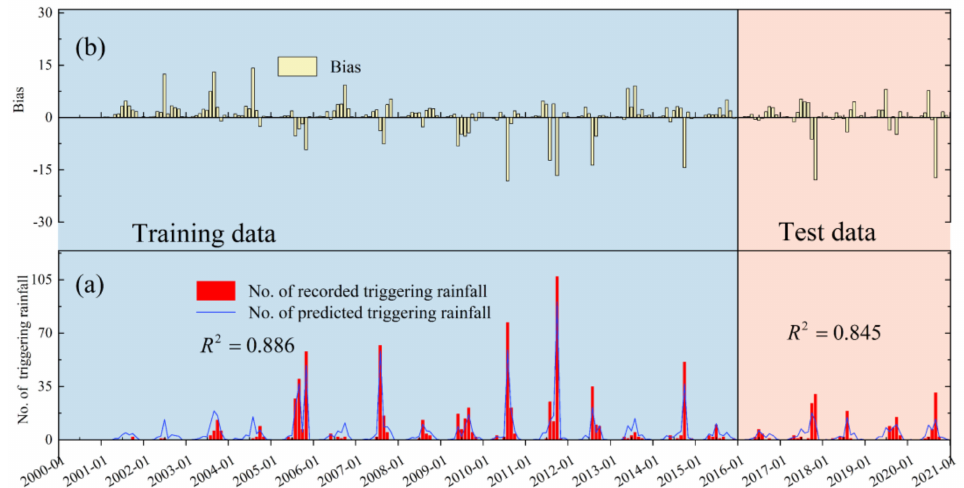
Figure 12. Verification results of the temporal probability model: ( a ) predicted triggering rainfall events vs. recorded triggering rainfall events, which is summarized by month. The red histogram refers to the number of triggered rainfall events per month, and the blue line refers to the number predicted by the model; ( b ) bias between the model prediction and actual recorded number of triggering rainfall events.